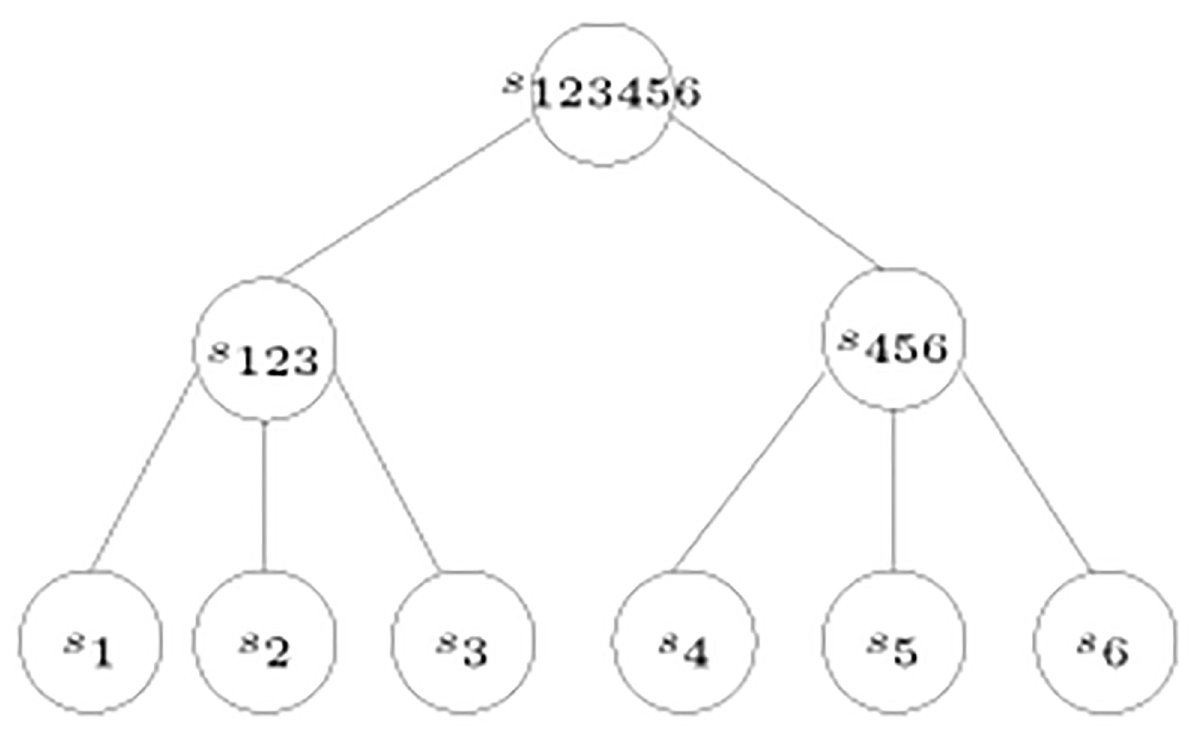
Fig 14. Tree corresponding to the posets in Fig